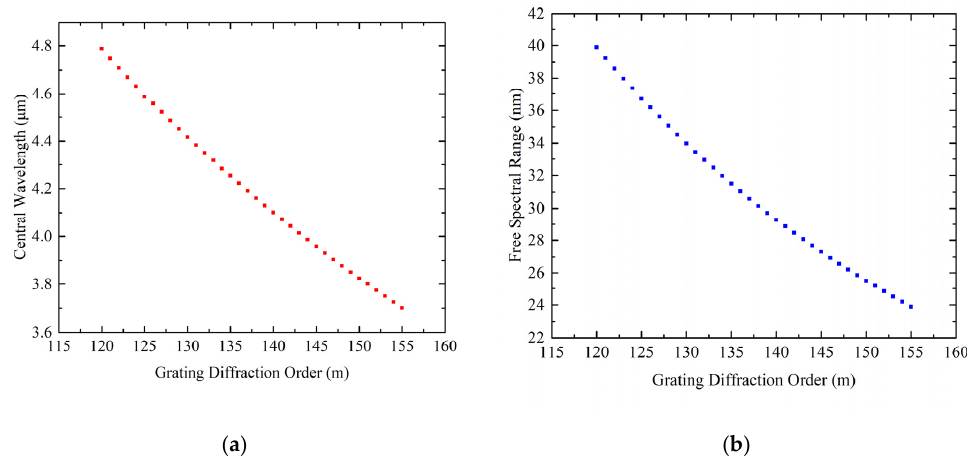
Figure 13. Plots of central wavelength, free spectral range, and diffraction order: ( a ) diffraction order versus center wavelength; ( b ) diffraction order versus free spectral range.